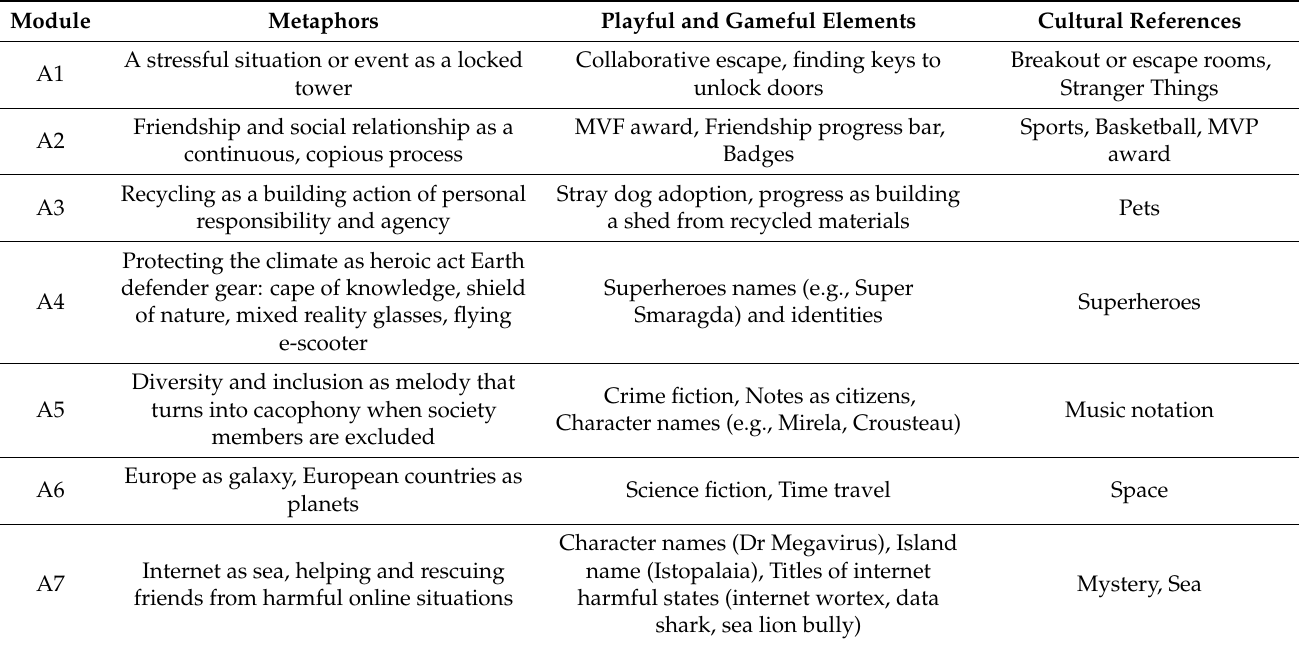
Table 3. Playful elements and metaphoric